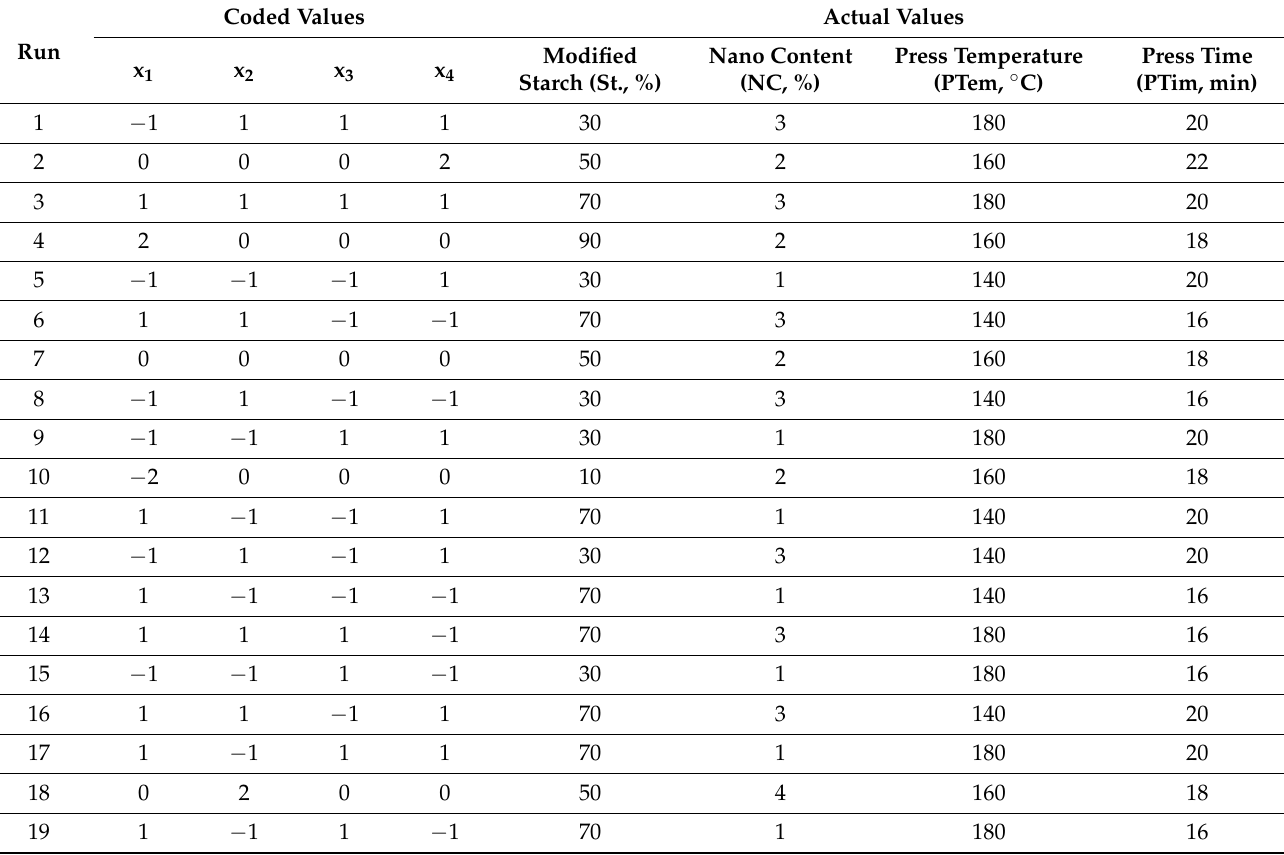
Table 2. Experimental design: coded and actual values of